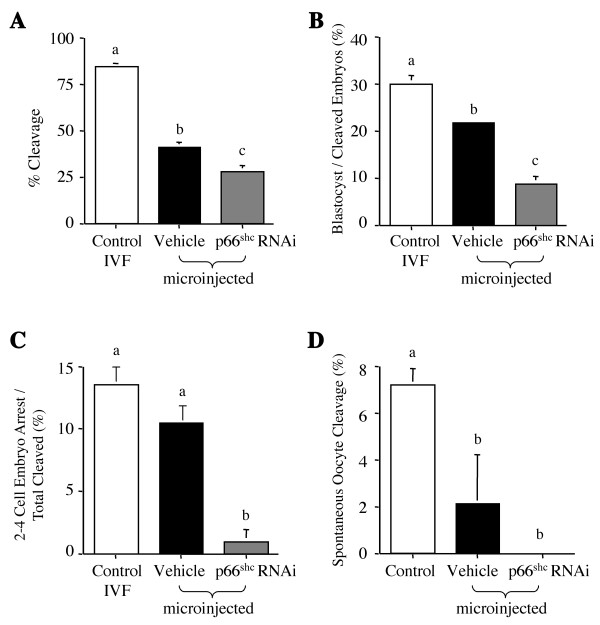
Assessment of cleavage, blastocyst, 2–4 cell embryo arrest and spontaneous embryo cleavage rates following microinjection with p66Shc hairpin RNAi molecules. Cleavage rate (A) and spontaneous cleavage rate (D) were evaluated at day-2 post insemination, while blastocyst rate (B) and arrest rate (C) were evaluated at day 8–9 post insemination. Although cleavage and blastocyst frequencies were significantly decreased (P < 0.001) in the embryos microinjected with the vehicle alone, an even greater significant decrease (P < 0.001) was observed in the p66Shc shRNAi microinjected oocytes (A, B). We observed a significant decrease (P < 0.05) in spontaneous oocyte cleavage rate following microinjection (D). A significant decrease in the frequency of arrested 2–4 cell embryos was achieved only following microinjection of short hairpin RNAi molecules against p66Shc (C). Bars with different letters represent significant differences between groups (P ≤ 0.05).